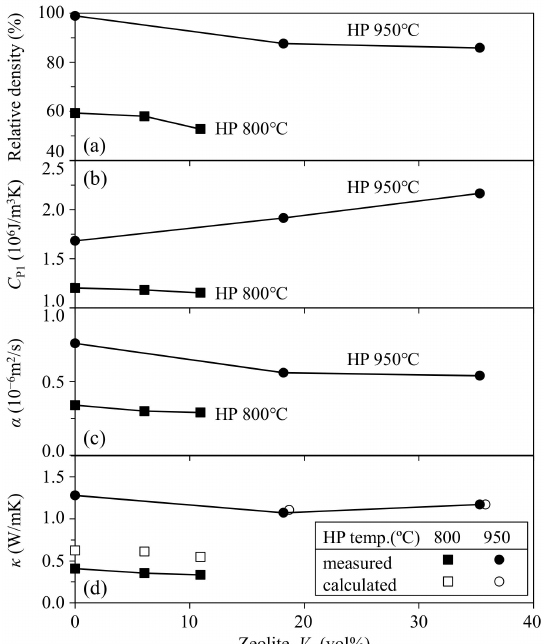
Figure 5. ( a ) Relative density; ( b ) heat capacity; ( c ) thermal diffusibility; and ( d ) thermal conductivity of zeolite–pore–shirasu glass composites at room temperature. The calculation of κ values for the composites was carried out using the thermal conductivity of 2.07 W/mK for mordenite